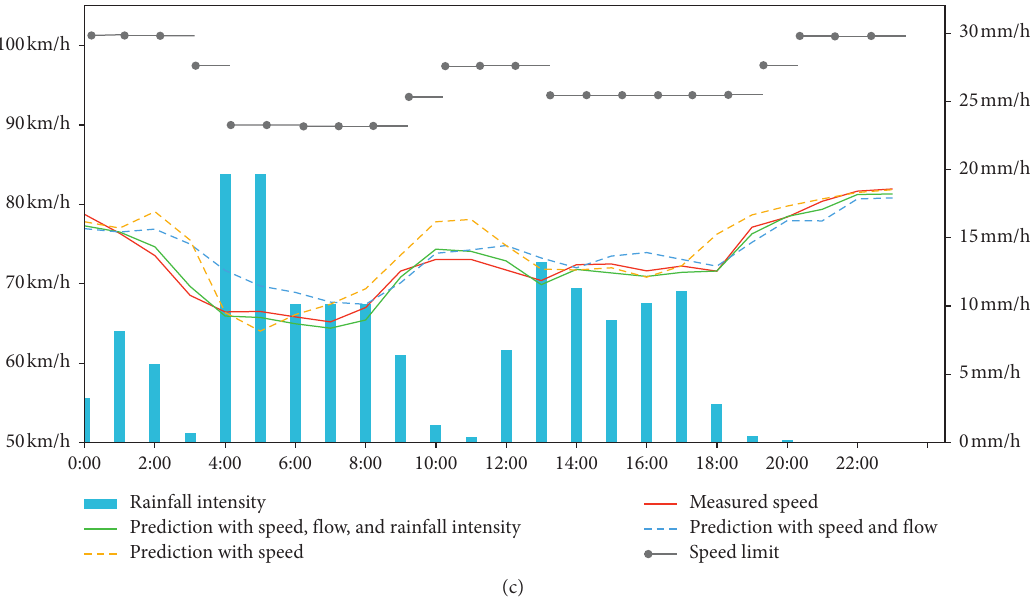
Figure 4: Travel speed prediction under three data combinations. (a) Travel speed prediction under three data combinations on June 26, 2018. (b) Travel speed prediction under three data combinations on July 3, 2018. (c) Travel speed prediction under three data combinations on July 4,